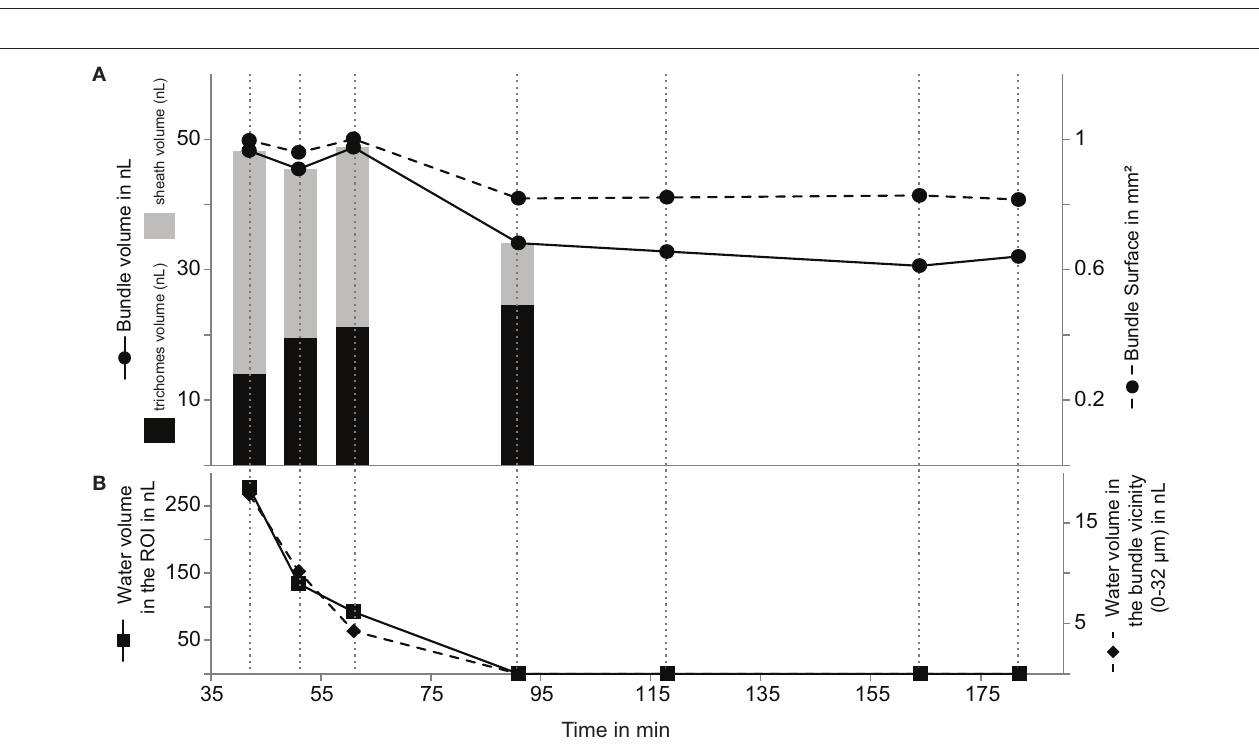
FIGURE 3 | Proportion of air and water filled pores, as well as volume occupied by sand grains in the 0–32 µ m microenvironment around the cyanobacterial bundle measured in increments of 4 µ m starting from the surface of the bundle.